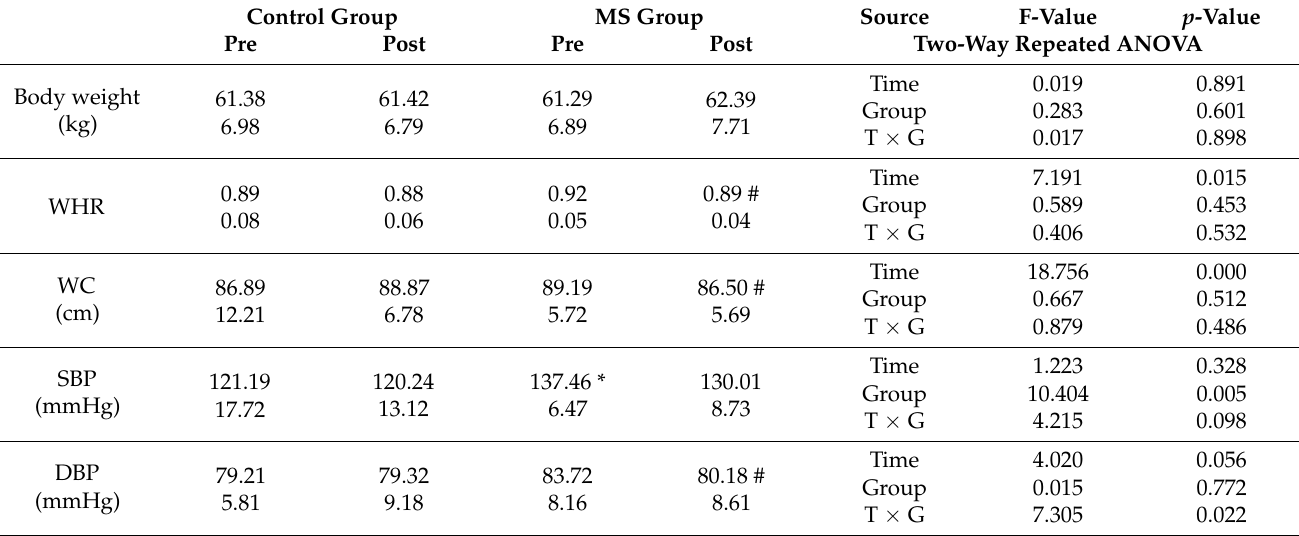
Table 2. Changes in body composition and blood pressure after exercise training.